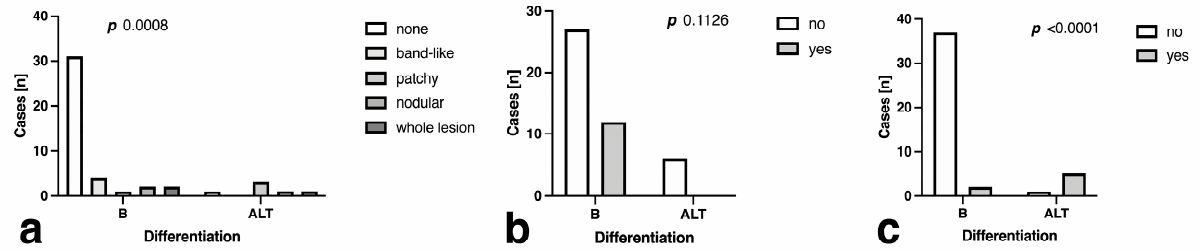
Figure 3. Bar plots demonstrating ( a ) septation morphology compared to surrounding fatty tissue and ( b ) maximum septation thickness in benign (B) tumors and atypical lipomatous tumors (ALT). Figure 4. Comparison of ( a ) intralesional short-tau inversion recovery (STIR) signal distribution, Outliers are depicted as circles. ( b ) presence of surrounding STIR signal and ( c ) presence of intratumoral signal without surrounding fluid in benign (B) tumors and atypical lipomatous tumors